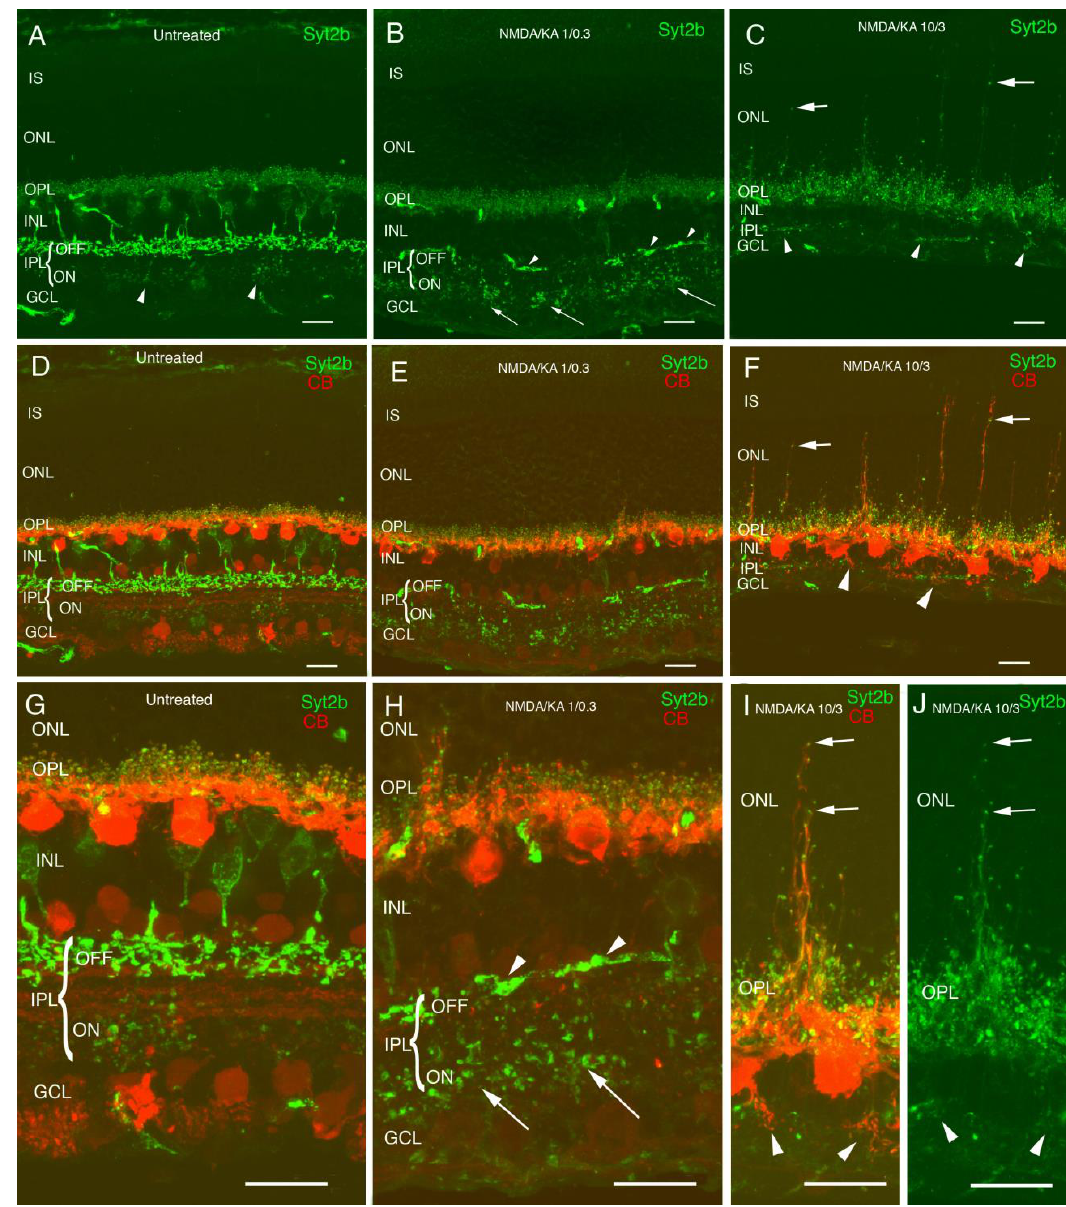
Figure 1. Morphological changes in OFF cone bipolar cells and horizontal cells in N-methyl-DL-aspartate (NMDA)/kainic acid (KA) treated retinas. Cryostat cross-sections immunostained with antibodies against Syt2b showing OFF and ON cone bipolar cells ( A ). Axon terminals of type 2 cone bipolar cells can be observed in the stratum of the OFF and those of type 6 cone bipolar cells stratify in the stratum of the ON showing less immunoreactivity intensity ( A , D arrowheads). Double immunolabeling with calbindin antibodies shows dendrites and axon terminals of horizontal cells in the OPL ( D , G ). NMDA/KA 1/0.3 treated retinas show OFF cone bipolar cell death, and only a few distorted axons remain in the stratum of OFF ( B , E , H arrowhead). In contrast, axon terminals of the ON cone bipolar cells can still be identified in the inner plexiform layer (IPL) stratum ON ( B , H arrows). At this dose, the terminals of the horizontal cells show a normal morphology, and only some sprouting can be observed ( E , H ). NMDA/KA 10/3 treated retinas induce a clear reduction of the inner retina. While the INL, IPL, and GCL layers show a drastic thickness decrease, the IS, ONL, and OPL layer thickness are maintained, indicating that photoreceptors are not affected by the treatment ( C , F ). Neither ON nor OFF bipolar cells can be detected ( C , F ) in this condition, and horizontal cells display abnormal dendrite sprouting towards the ONL ( C , F , I , J arrows) and the IPL ( C , F , I , J arrowheads). IS—inner segments; ONL—outer nuclear layer; OP—outer plexiform layer; INL—inner nuclear layer; IPL—inner plexiform layer; GCL—ganglion cell layer. All of the images were obtained from temporal retina, ca. 500 µm from the optic disk. Scale bar of 10 µm.